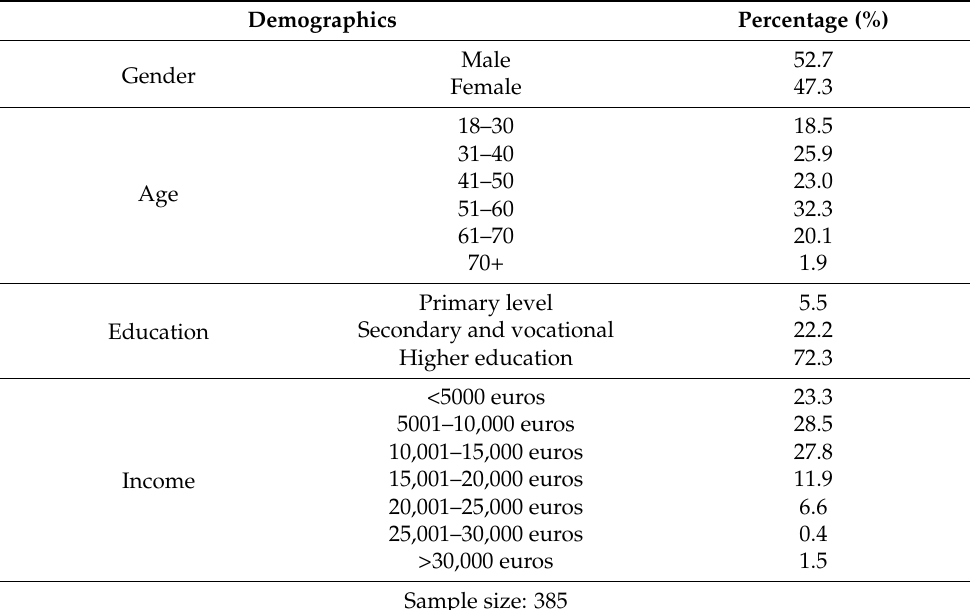
Table 3. Demographic information for the sample under